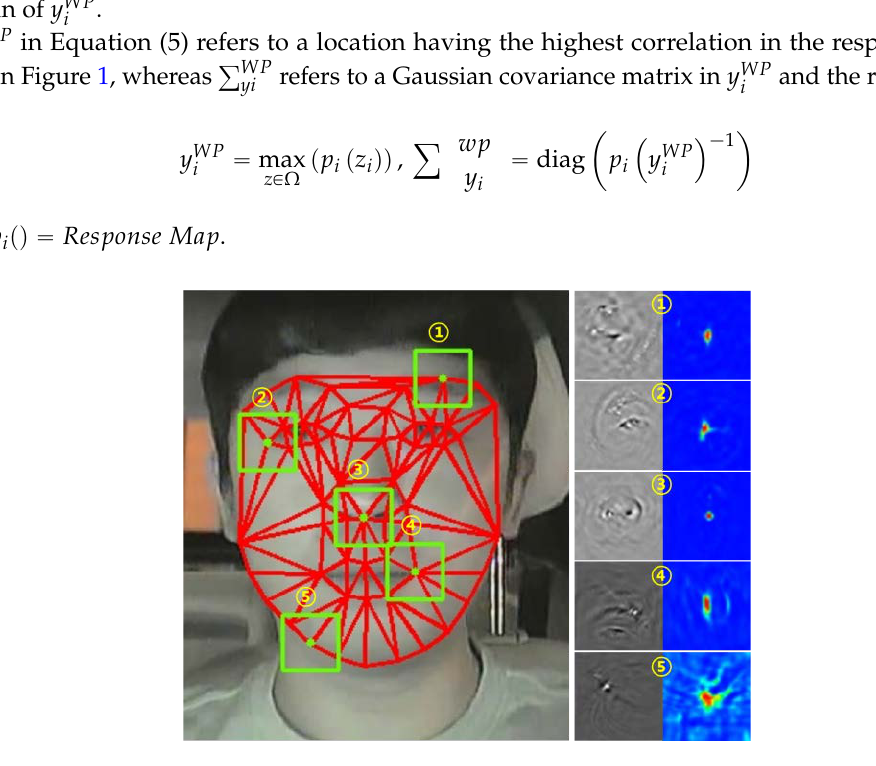
Figure 1. Appearance of MOSSE (Minimum Output Sum of Squared Error)filter and response map on a PDM (Point Distribution Model)shape: the PDM shape on a given face having 56 landmarks ( left ); the MOSSE filters at five sampled locations ( middle ); and their corresponding response maps ( right ).